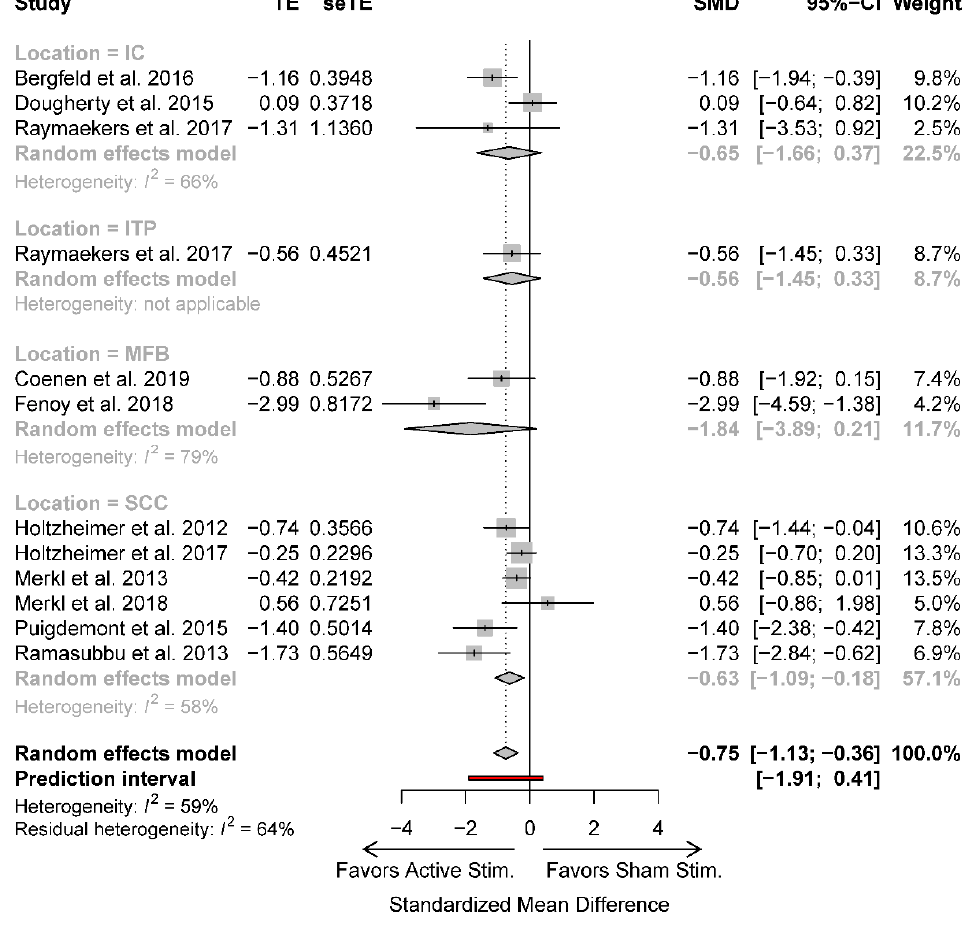
Figure 3. Meta-regression forest plot comparing various stimulation targets. CI: confidence interval; IC: internal capsule; ITP: inferior thalamic peduncle; MFB: medial forebrain bundle; SCC: subcallosal cingulate; SMD: standardized mean di ff erence; TE: treatment e ff ect; seTE: standard error of treatment e ff ect.